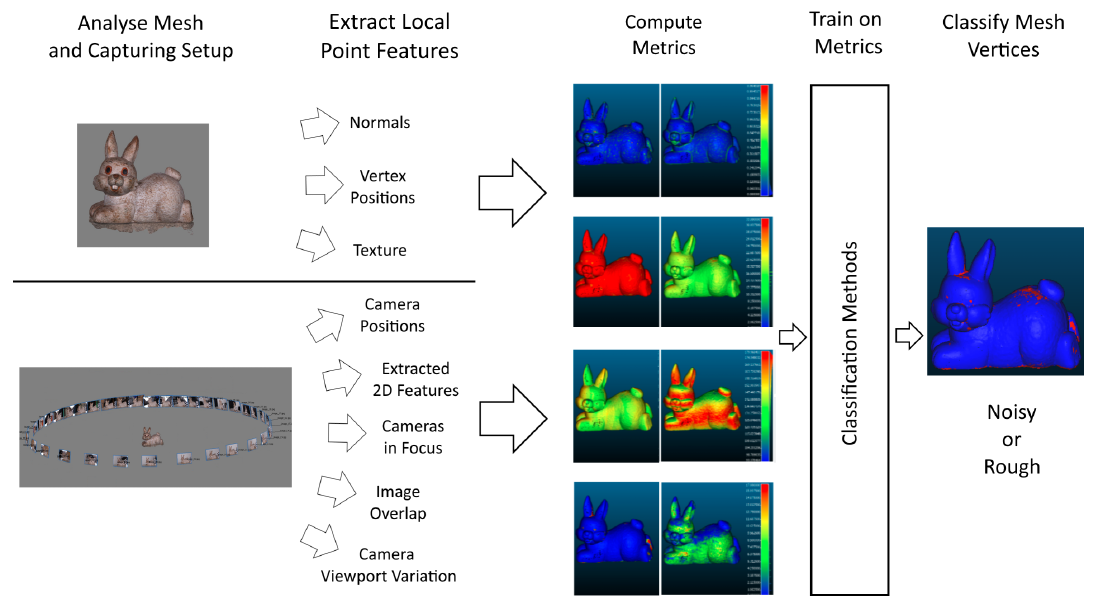
Figure 2. Overview of the proposed idea for using metrics extract from the mesh and capturing setup used for SfM reconstruction, to determine if the underlying surface is noisy or